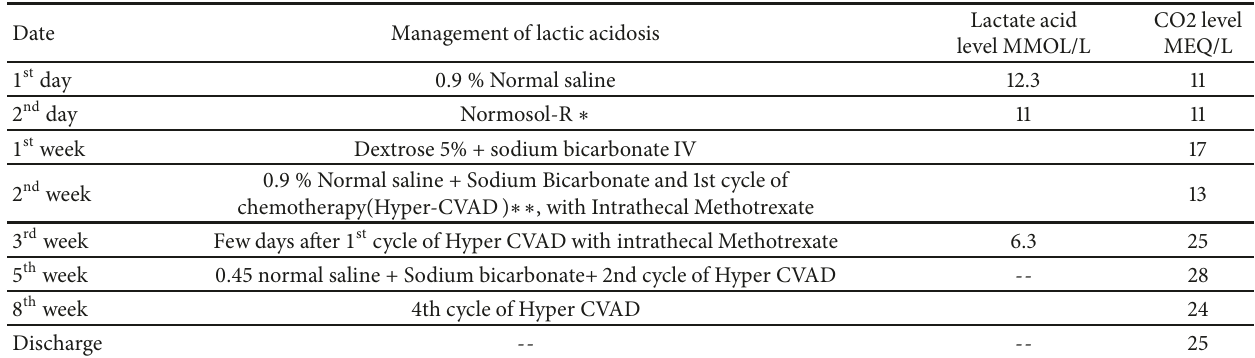
Table 2: Explanation of the hospital course management of lactic acidosis.